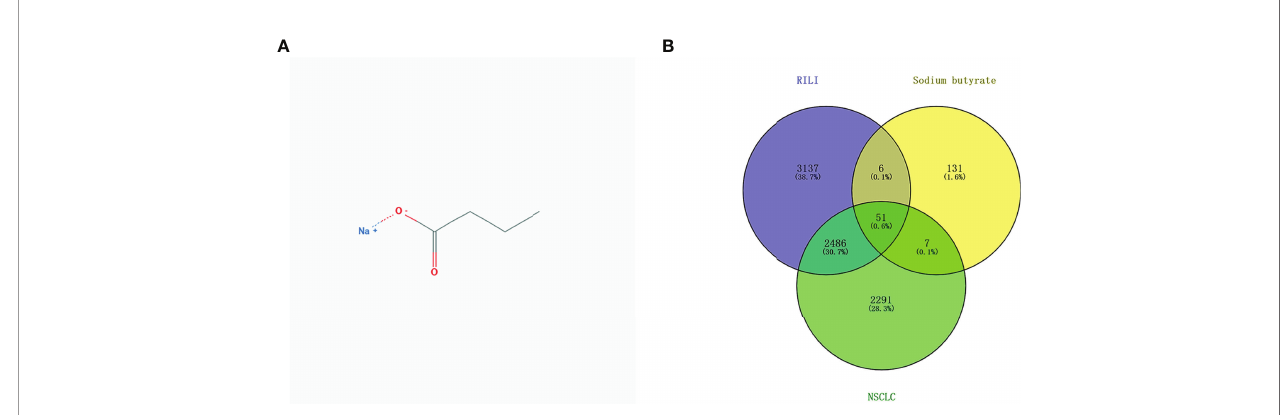
FIGURE 2 | 2D structural information of sodium butyrate (A) ; Venn diagram of involved genes of sodium butyrate, RILI and NSCLC